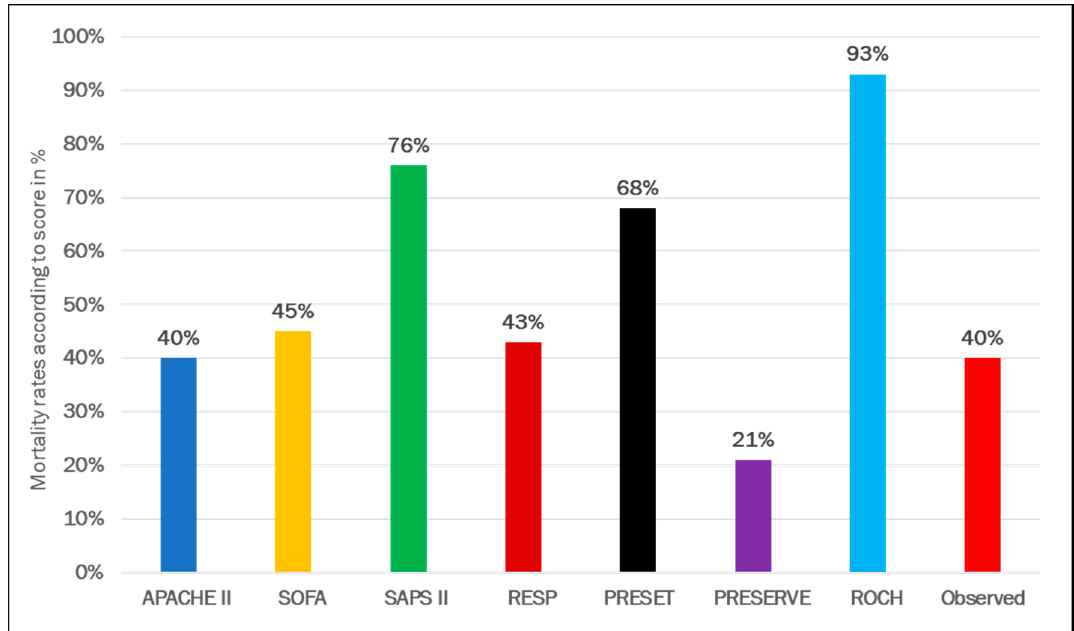
Figure 5. Comparison of predicted and observed mortality rates in patients supported with veno-venous extracorporeal membrane oxygenation.